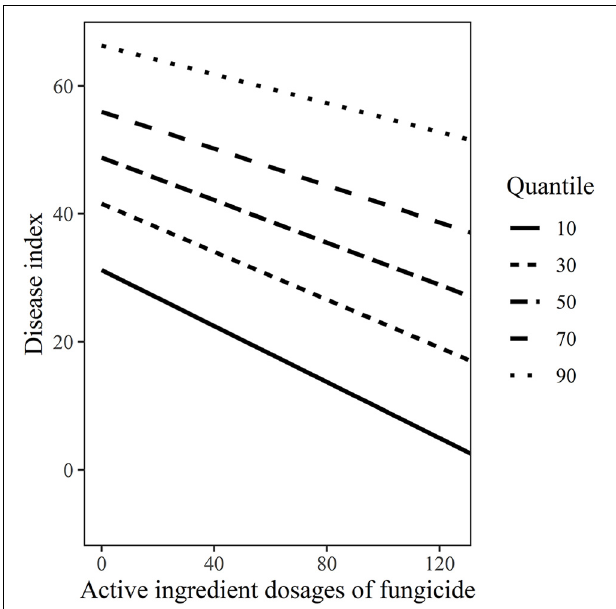
FIGURE 2 | The variability disease index of wheat powdery mildew with active ingredient dosages of fungicides based on the10, 30, 50, 70, and 90% quantile